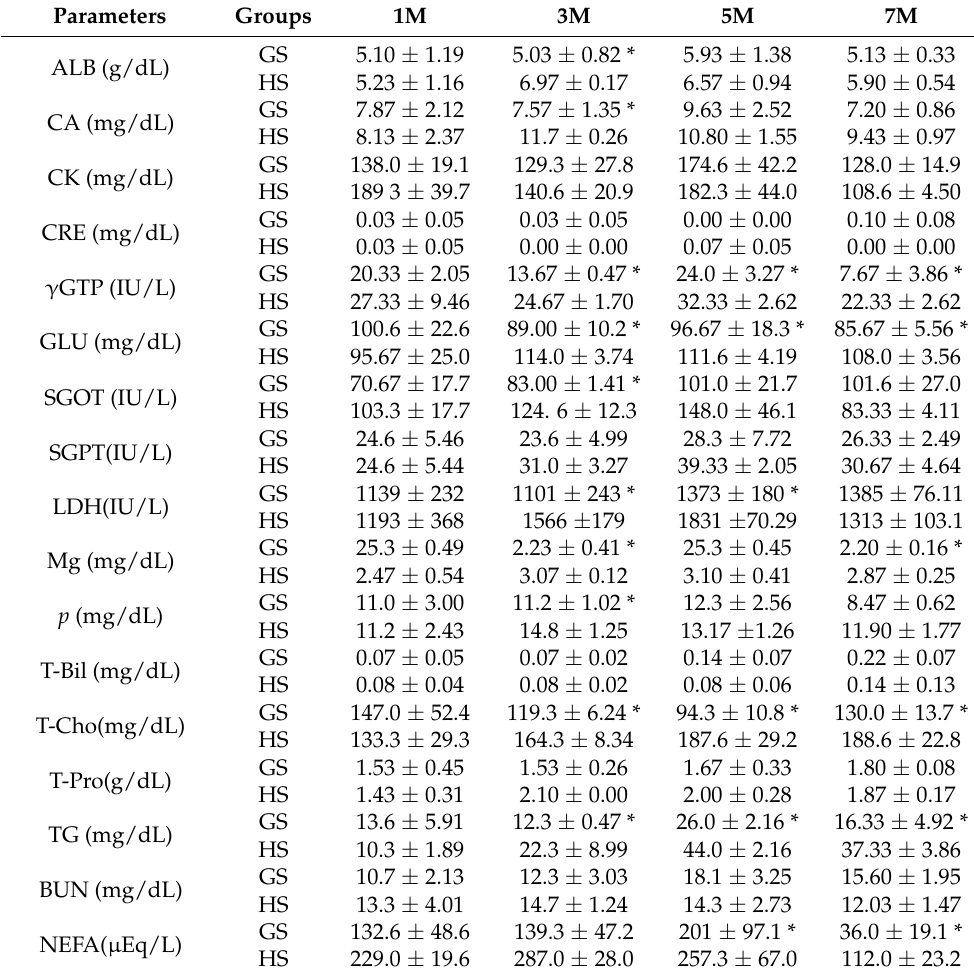
Table 1. Physiological parameter changes in the serum of GS and HS in different